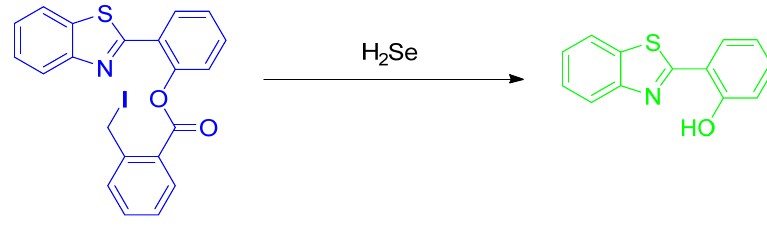
Figure 44. Structure of HBT – Se and its reaction towards H 2 Se by Xin et al.